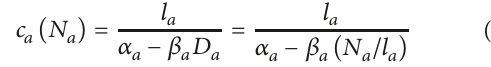
defined to be the density at which the speed across the link is 0, is also directly derivable as 𝐷 𝑚𝑎𝑥 𝑎 = 𝛼 𝑎 /𝛽 𝑎 . Therefore, 0 ≤ 𝐷 < 𝛼 /𝛽 𝑎 𝑎 𝑎 .